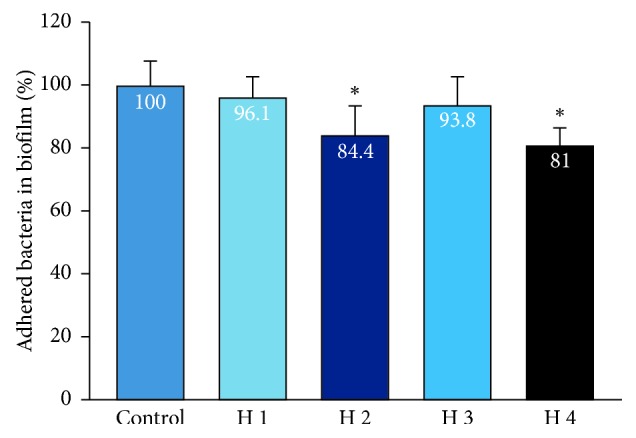
Bacterial biofilm resistance of PRP of the healthy group. Data show the percentage of bacteria in the biofilm of the control group, n = 4; the error bar represents the standard deviation. ∗indicates the Wilcoxon nonparametric test showed significant differences in mean biofilm reduction between the PRP of subjects and the control group (P < 0.05).